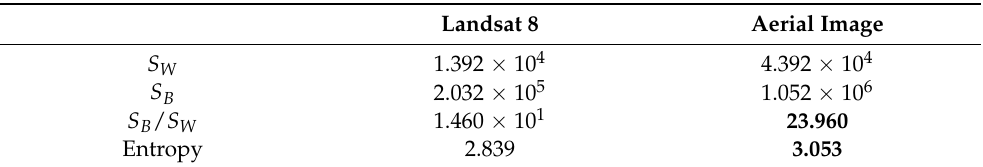
Table 4. Fisher’s linear discriminant analysis, including the within-class scatter metric ( S W ), between- class scatter metric ( S B ), S B / S W , and information entropy of the classification results of GIC for the RGB composites of the Landsat 8 and aerial